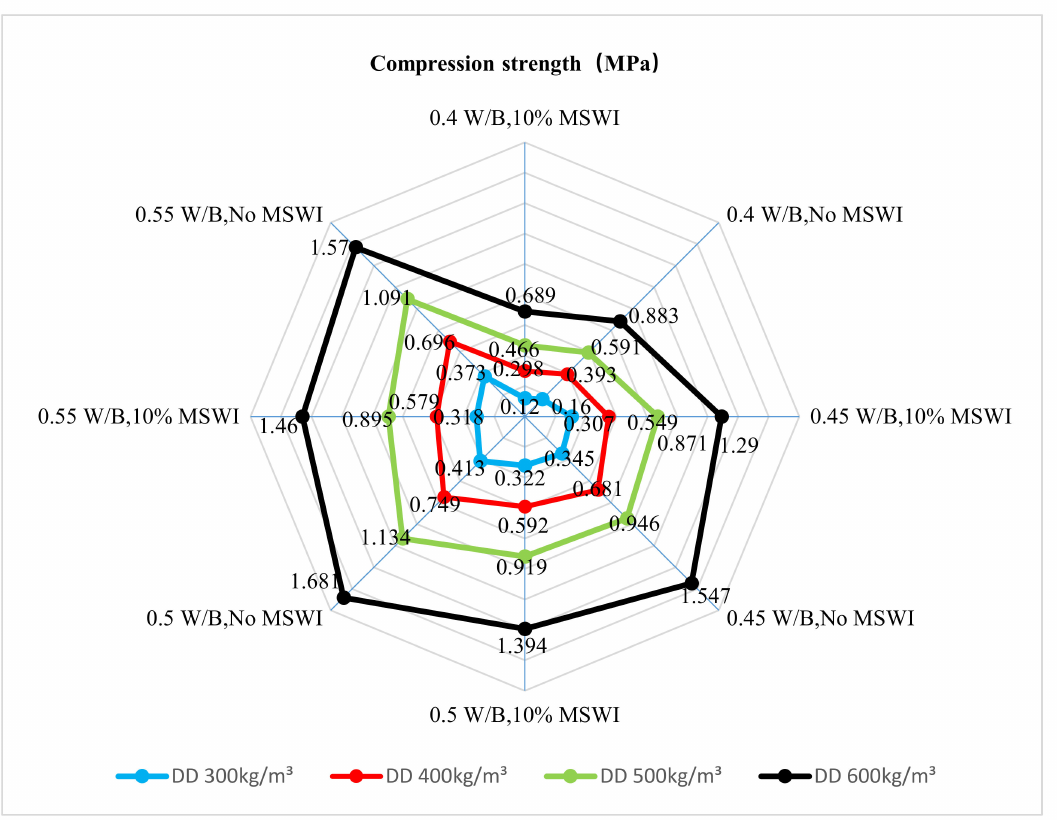
Figure 5. Compressive strength of recycled foamed concrete with MSWI powder with different w/c